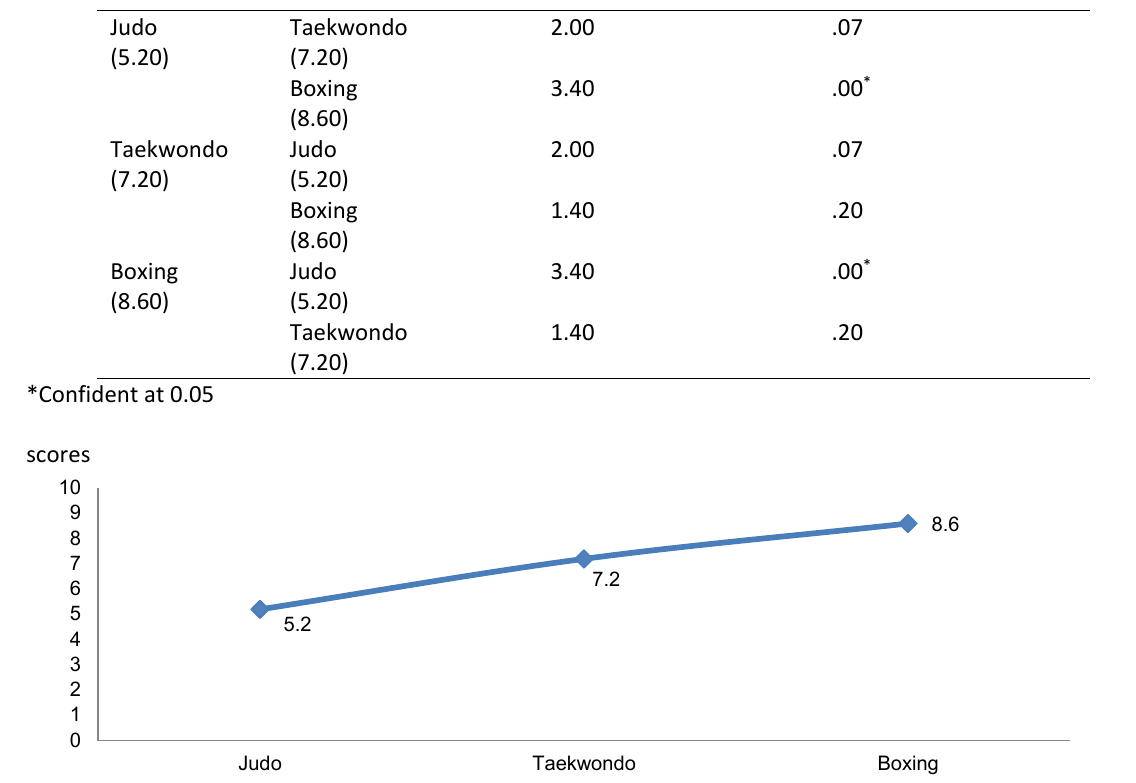
Figure 4. Graphical representation of mean scores with regard to judo, taekwondo and boxing players on the sub-parameter coach